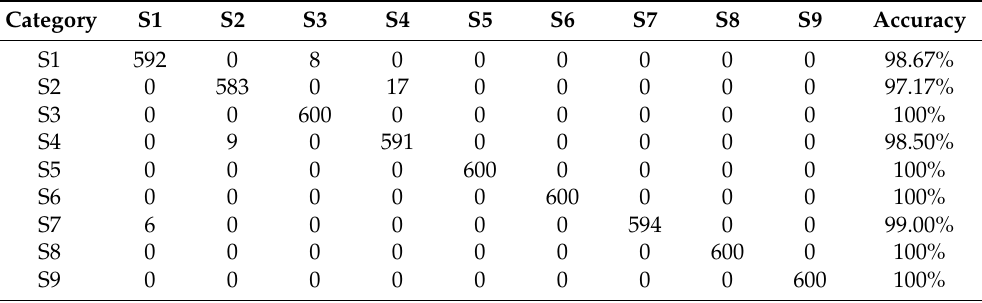
Table 2. PNN classification results with the favorable width factor combination.